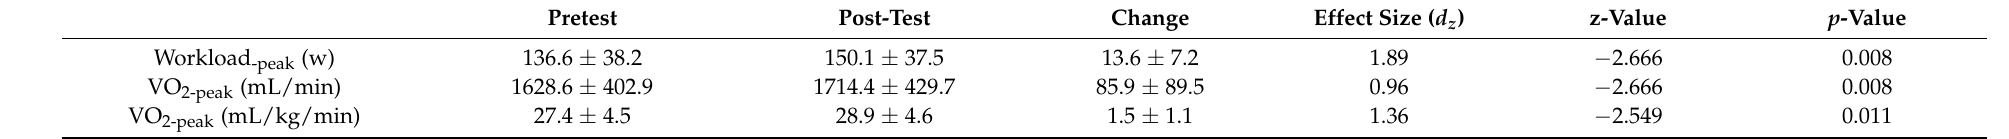
Table 2. Means and SD for pretest, post-test, and changes in aerobic